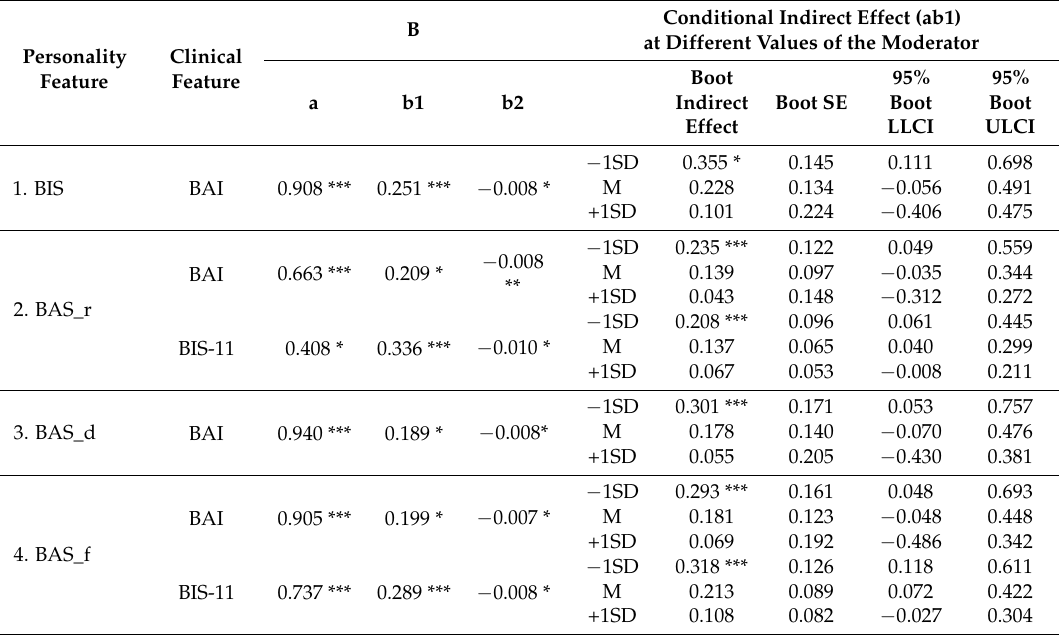
Table 5. Regression results for moderated mediation model in girls.